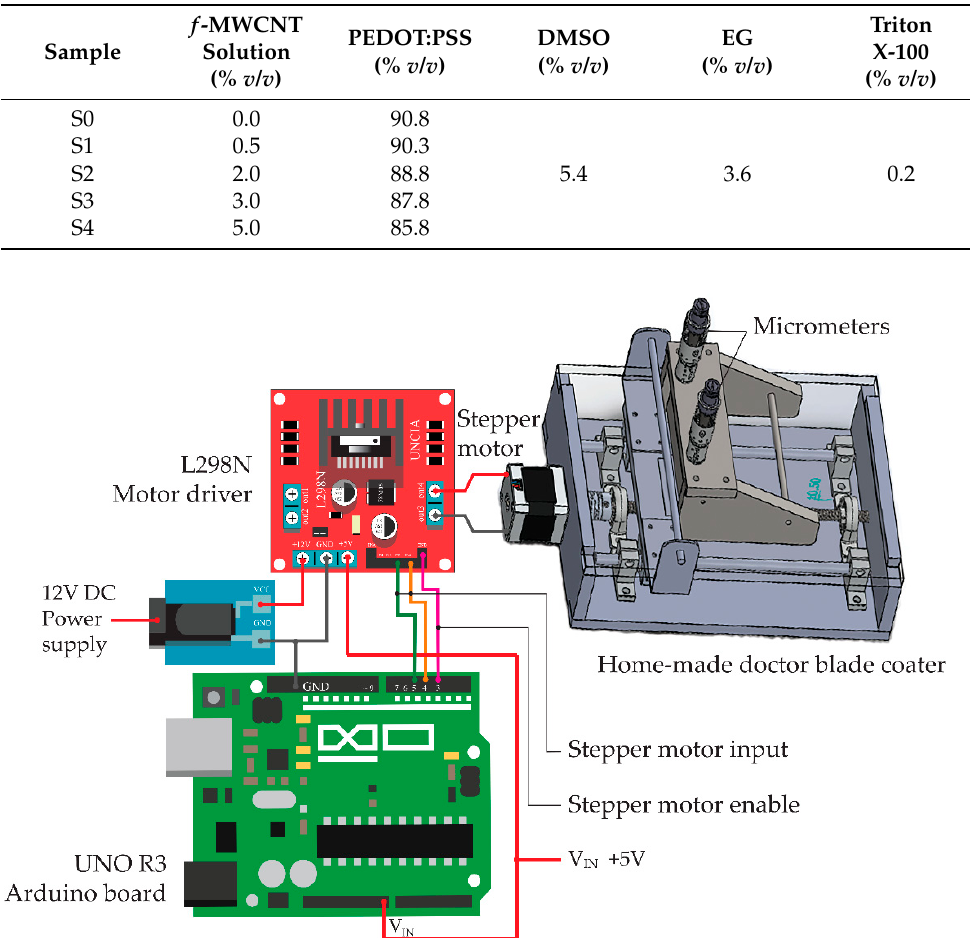
Figure 1. Schematic illustration of screen-printing system.